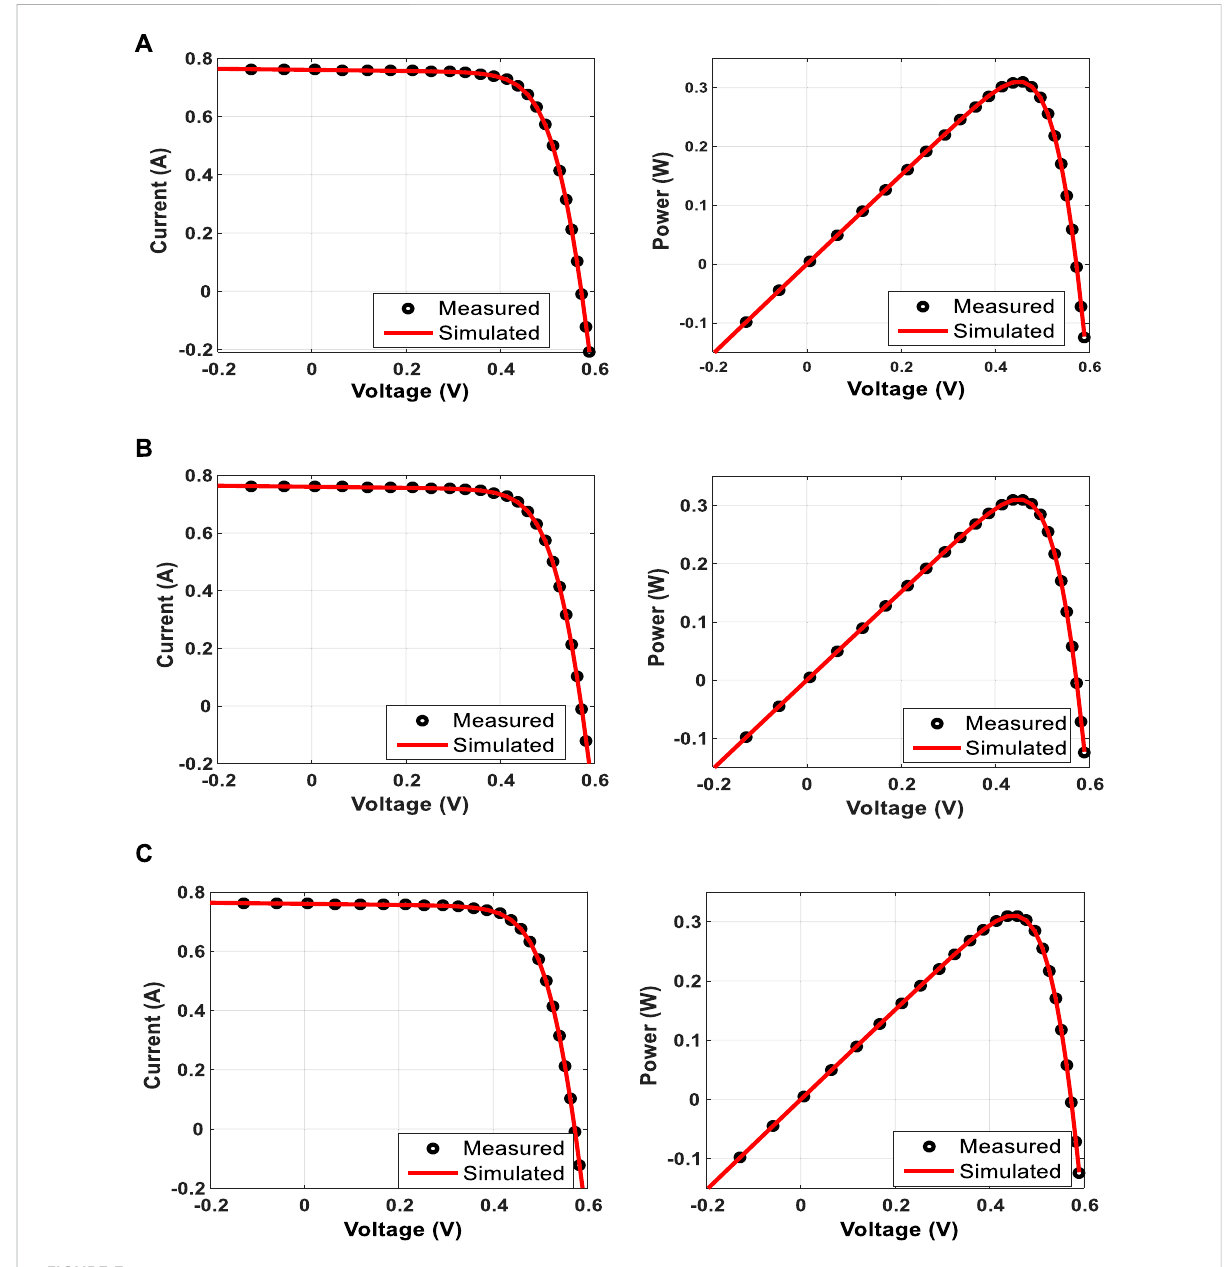
FIGURE 3 Measured and simulated curves obtained via CapSA for the R.T.C France PV cell. (A) SDM, (B) DDM, and (C)